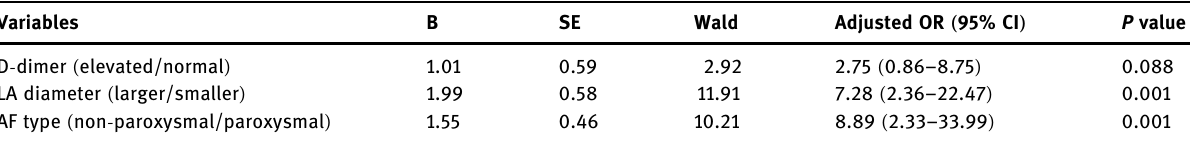
Table 3: Logistic regression analysis to evaluate risk factors of LAAT